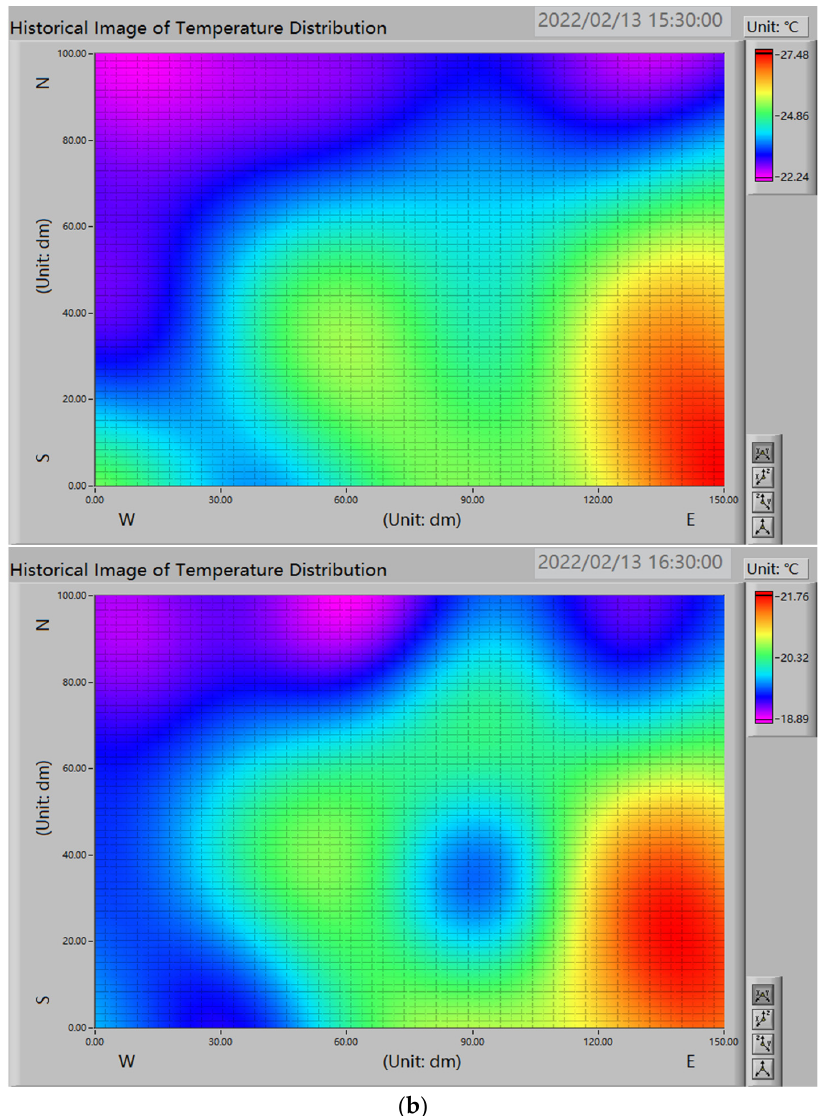
Figure A7. The horizontal temperature distribution of typical sunny days in winter was 9:30, 10:30, 11:30, 12:30, 13:30, 14:30, 15:30, and 16:30. ( a ) Temperature distribution on 9 February 2022; ( b ) Tem- perature distribution on 13 February 2022.